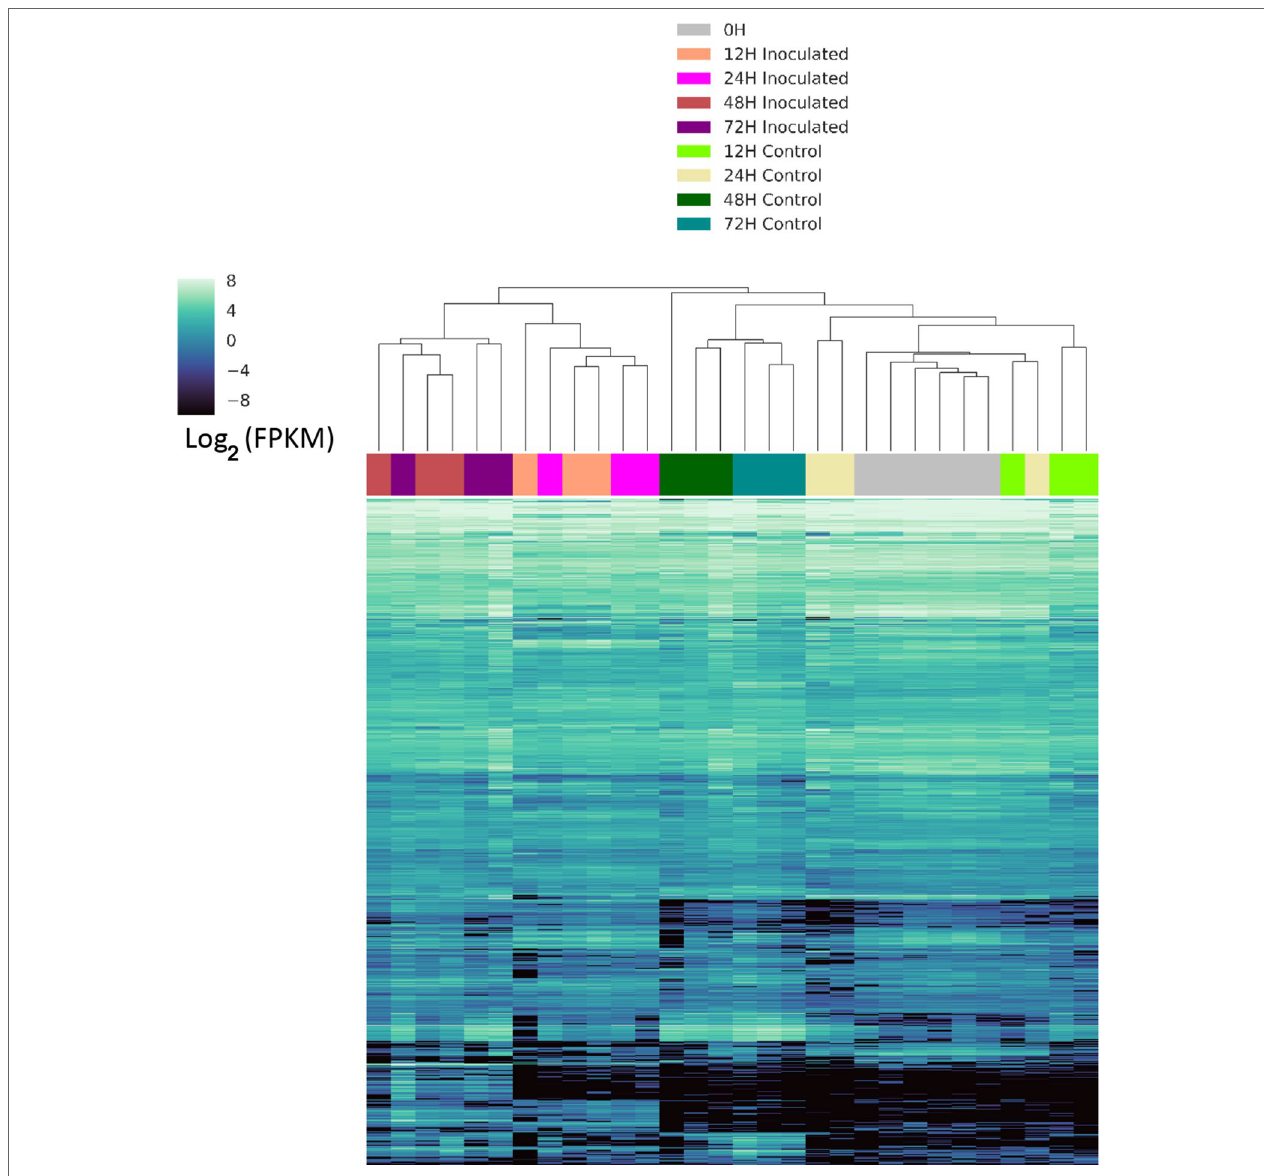
FIGURE 3 | Clustered heatmap of differentially expressed genes. Expression is reported as Log 2 of the fragments per kilobase of gene per million read pairs. Samples were clustered and visualized using the Seaborn clustermap function, which uses Euclidian distance metrics to generate a linkage matrix used for hierarchical clustering. X-axis across the top is the is dendrogram of samples at individual time points and conditions, indicated by the color key, while the genes are represented by individual lines on the Y axis as sorted by the clustermap function.